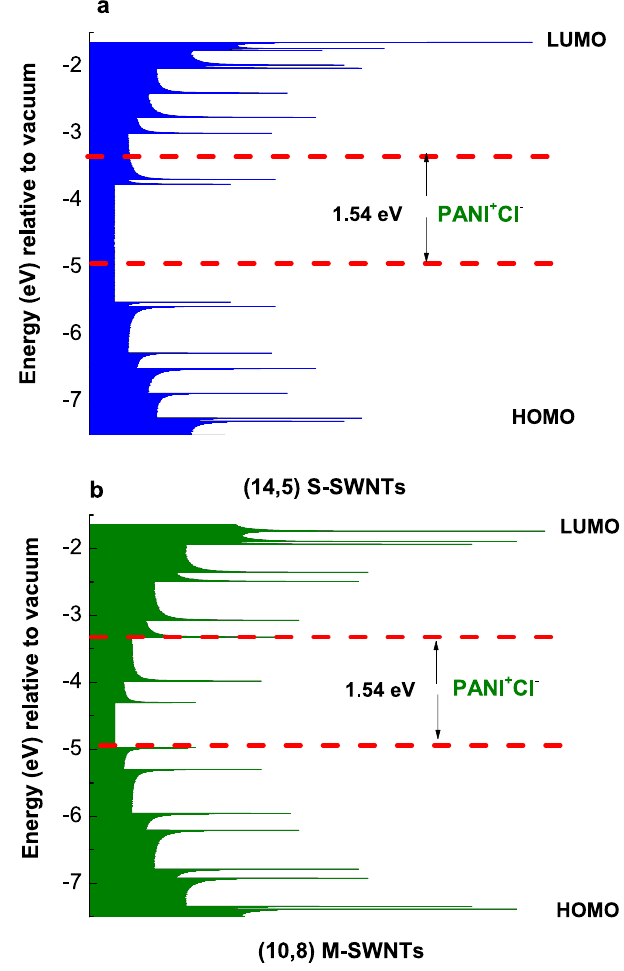
Figure 7. Diagram of electronic energy levels of S-SWNTs ( a ), M-SWNTs ( b ) and PANI doped with Cl − ions (red